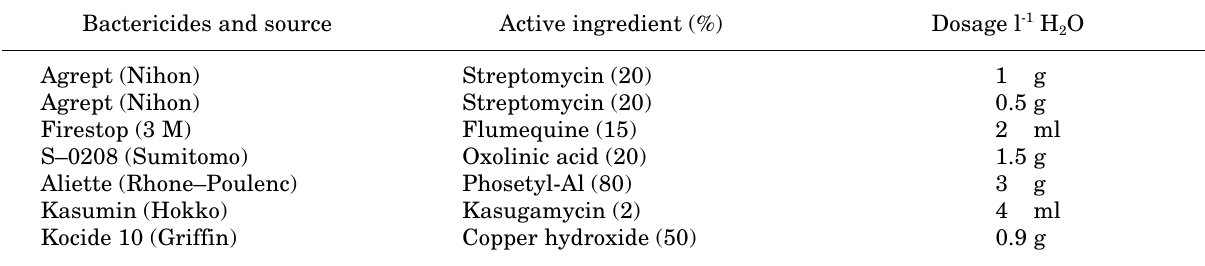
Table 1. Bactericides used in the experiments. Bactericides and